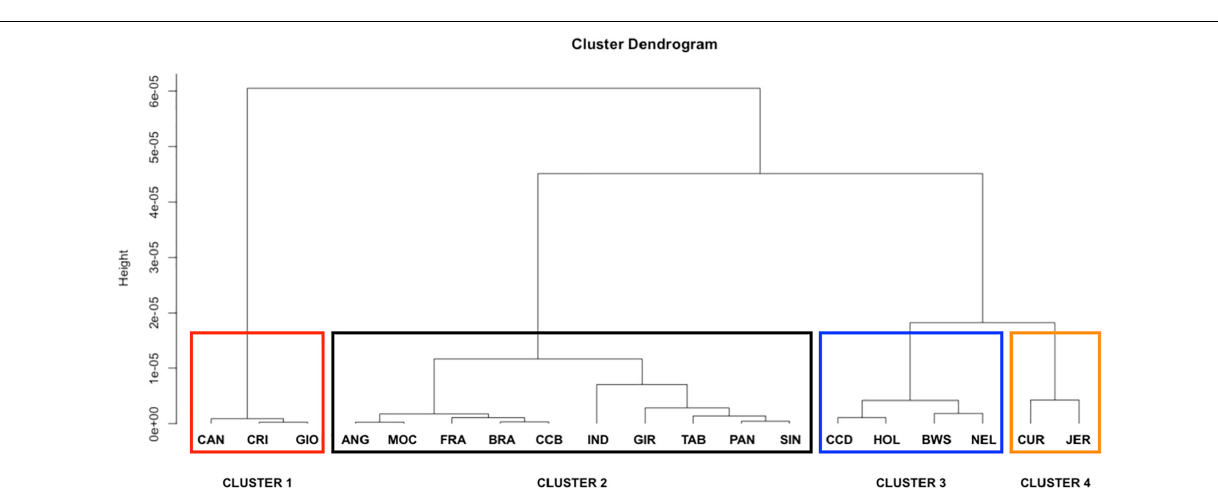
( Supplementary Figures 1–3 ). Several biological processes were highlighted, including neutrophil-mediated killing of bacteria, interferon-alpha response, and prolactin signaling